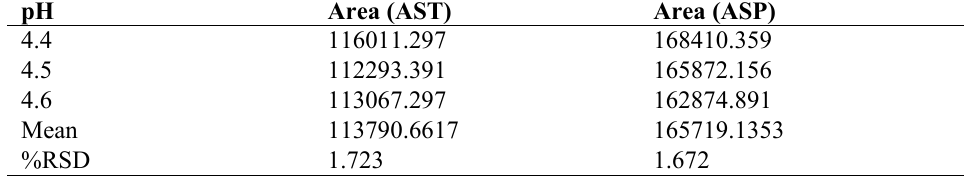
Table 6. Robustness for pH studies.